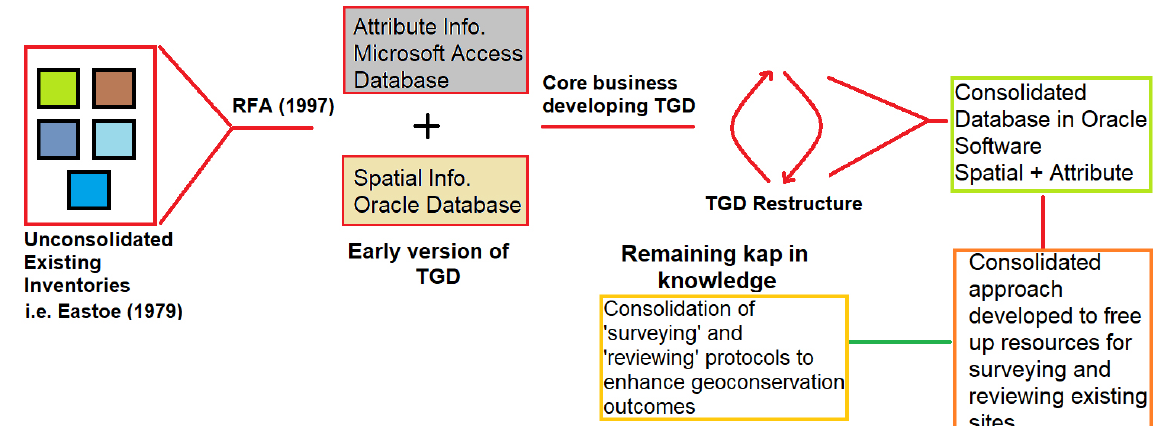
Figure 1. Consolidation trends in the establishment of the TGD. The Regional Forest Agreement in 1997 stimulated the first consolidated TGD database. Subsequently, a TGD restructure further consolidated the TGD to include both spatial and attribute